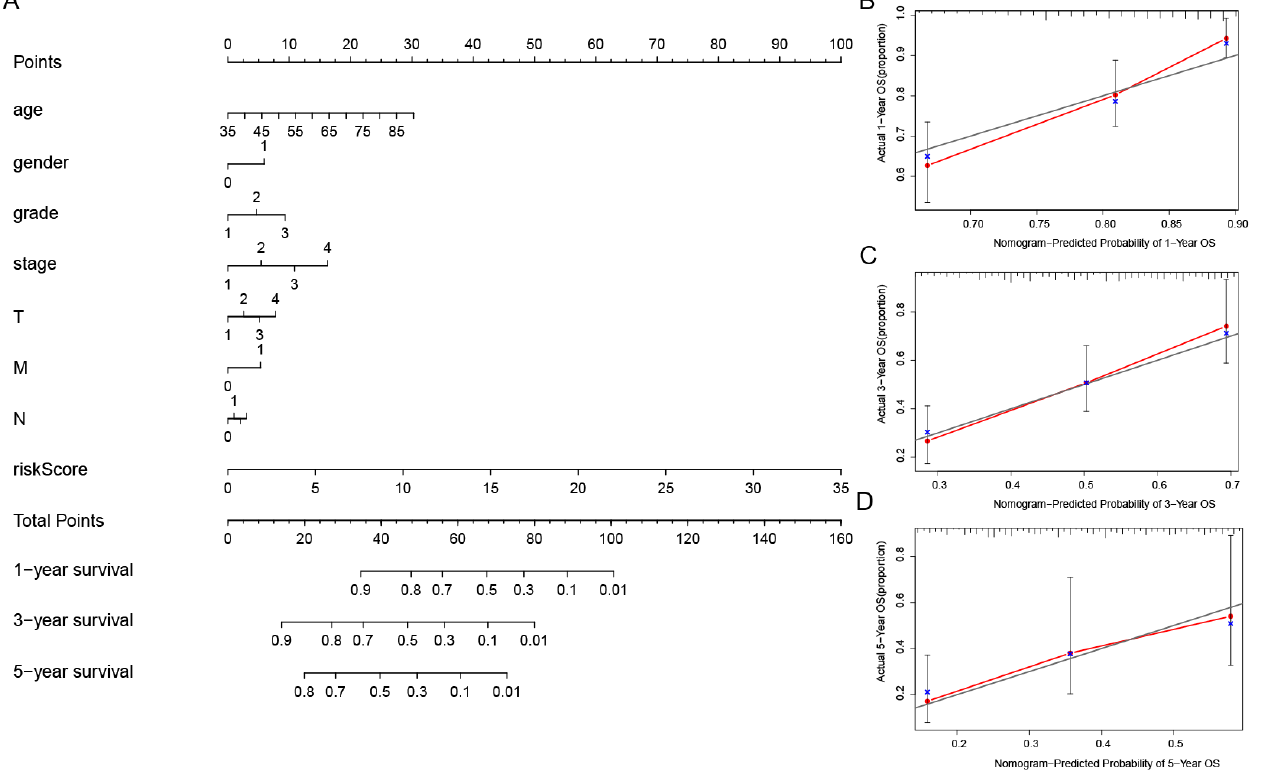
Figure 6. Establishment of the nomogram of the predicted signatures, as well as the verification of its reliability. ( A ) The one-, three-, and five-year OS in patients with GC, as forecasted by the nomogram containing the clinicopathological variables and risk scores. ( B – D ) The calibration curves that were used in order to explore whether the actual OS rates were consistent with the predicted survival rates. Perfect prediction would correspond to the grey line. The blue dots represent the actual incidence. The red line is the predicted fitting line obtained by bias correction.